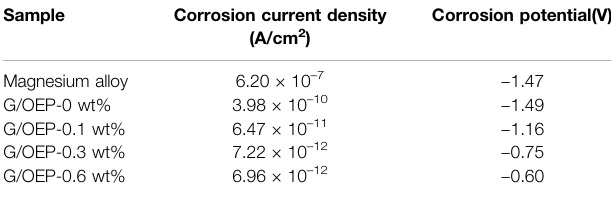
TABLE 2 | Related parameters of potentiodynamic polarity